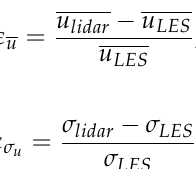
, red) of synthetic LiDAR data as (cid:3296) u